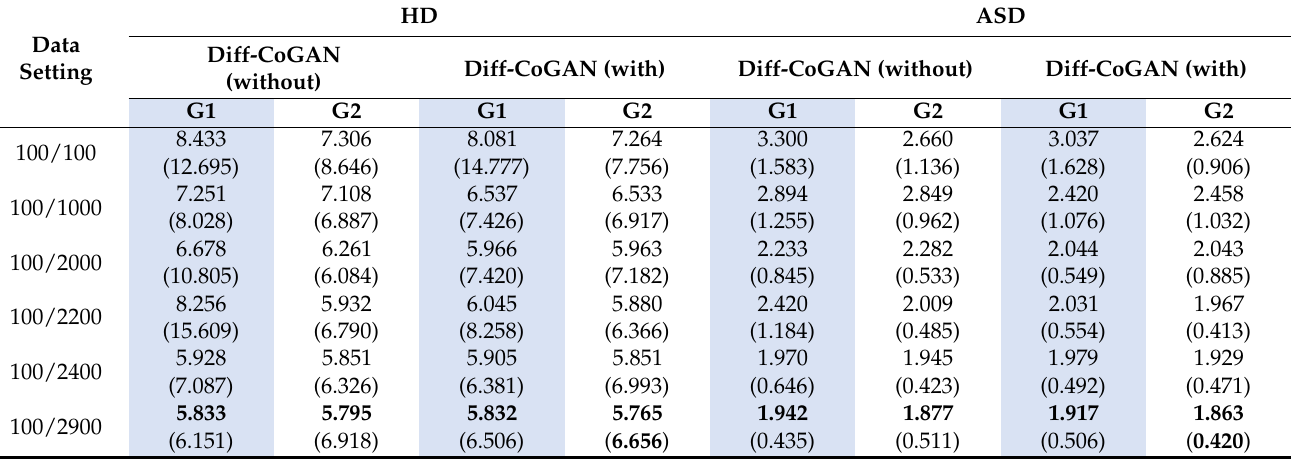
Table 6. The HD and ASD values of Diff-CoGAN with and without intersection prior to the input of the discriminator. Using the Hippocampus dataset, the intersection operation shows that it is able to reduce the boundary errors in segmentation. Diff-CoGAN with intersection consistently shows lower values of ASD and HD compared to Diff-CoGAN without